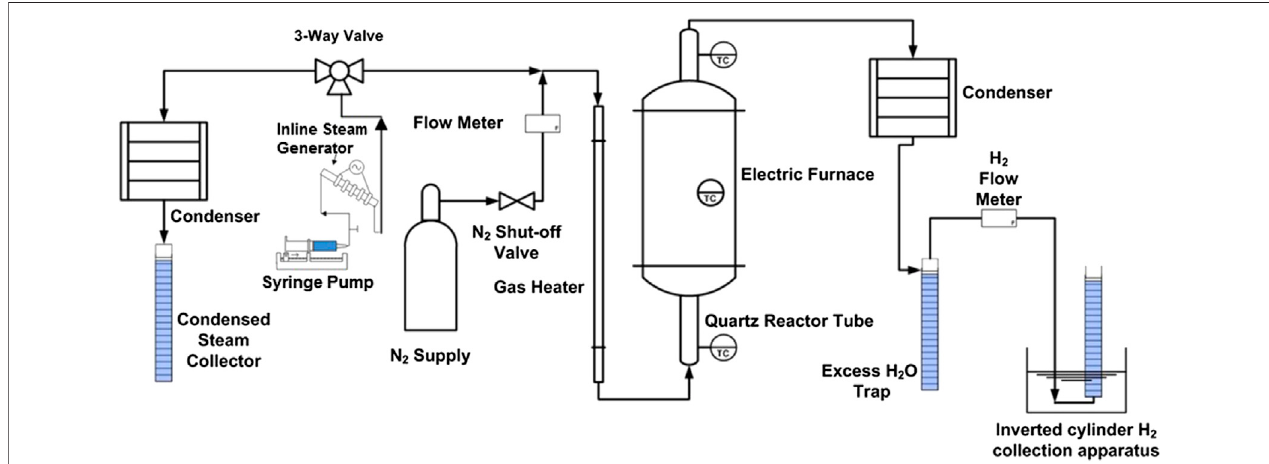
FIGURE 1 | Experimental Hydrogen production facility.